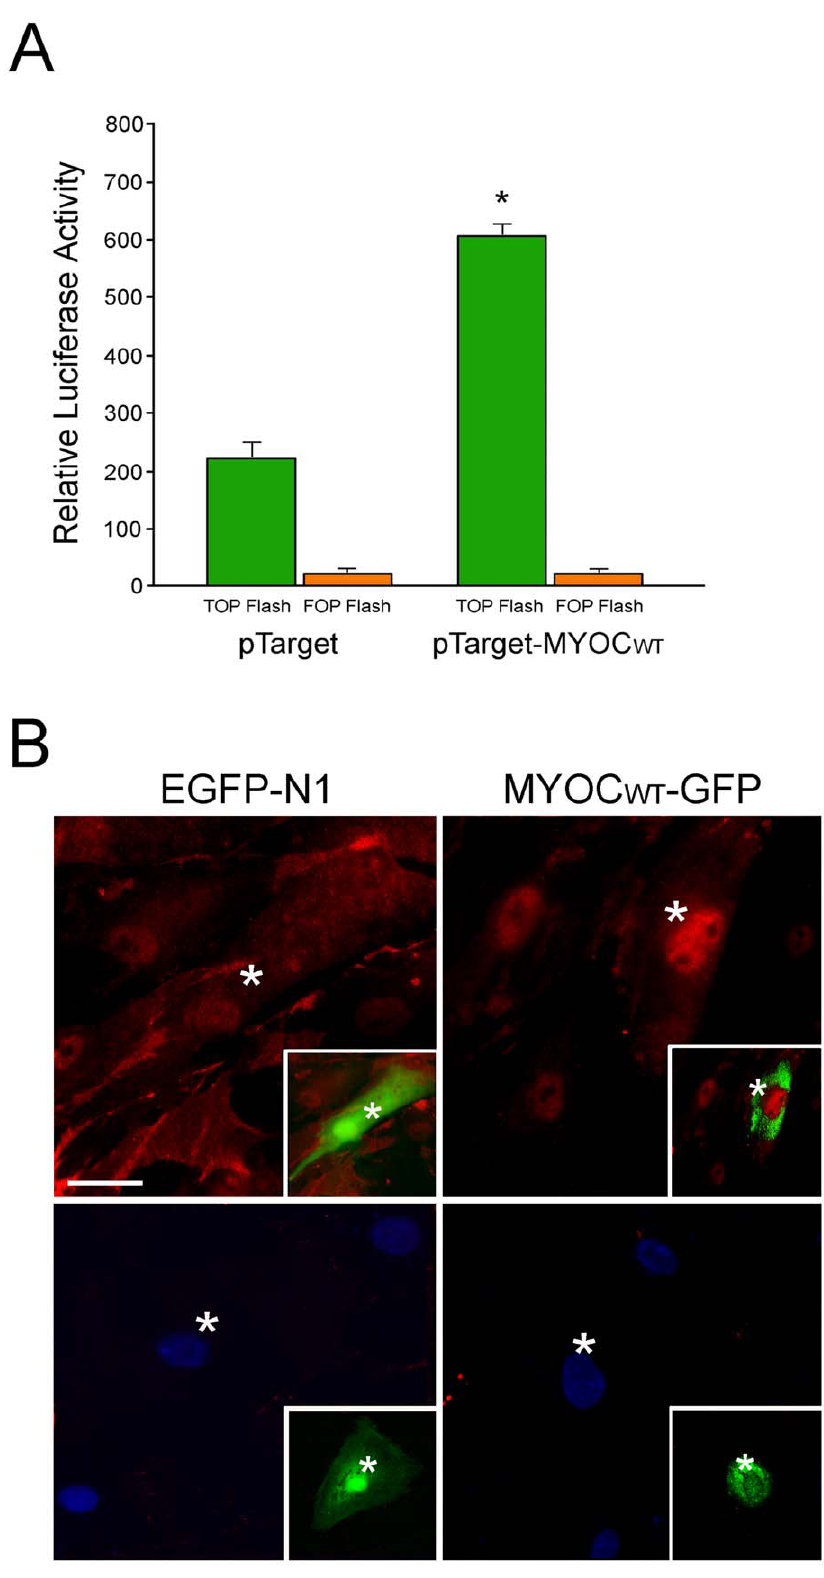
Figure 3. A. Myocilin expression activates Tcf/Lef-dependent transcription in Caco-2 cells. Caco-2 cells were co-transfected with TOP- or FOP-Flash reporter construct, and pTarget-myocilin WT (pTarget-MYOC WT ) or pTarget plasmid for 48 h. A pEGFP-N1 vector was also co-transfected for standardization. Luciferase activity measured was normalized to the GFP reading. Three experiments were performed in triplicate. Results (mean 6 SEM) from a representative experiment are shown. *, P , 0.001 compared to pTarget control. B . b -catenin (red) staining (top panel) in human TM cells